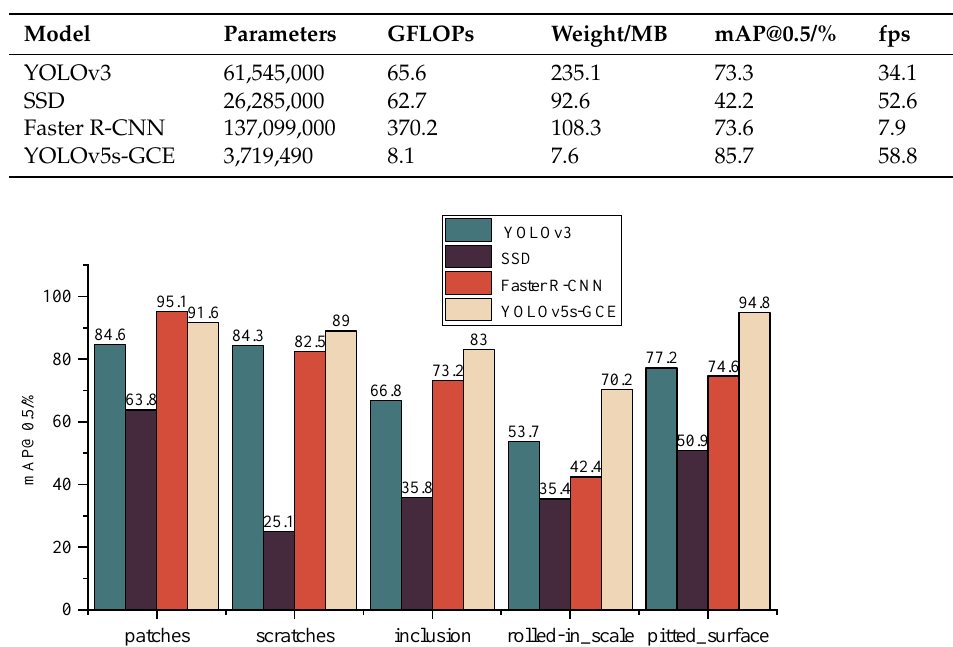
Figure 9. Detection results of various defects by different algorithms.